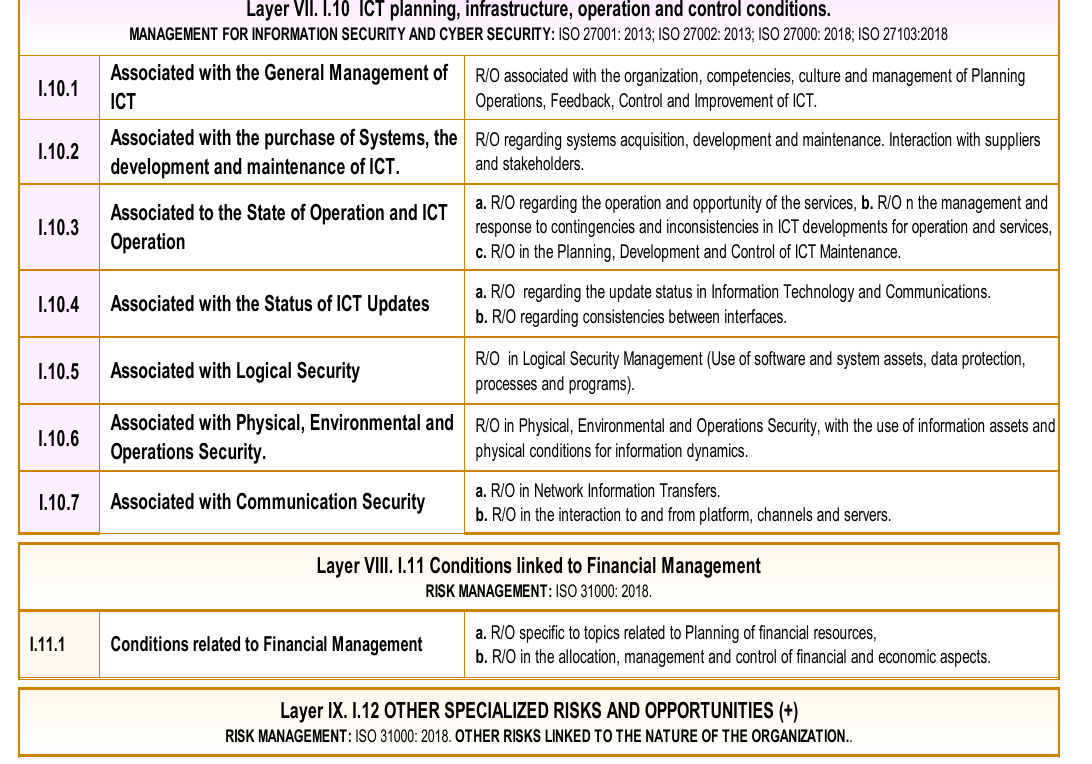
Figure A14. Classification matrix of topics related to internal R / O. Layers VII: I.10, VIII: I.11 and IX: I.12 [17,29,30].